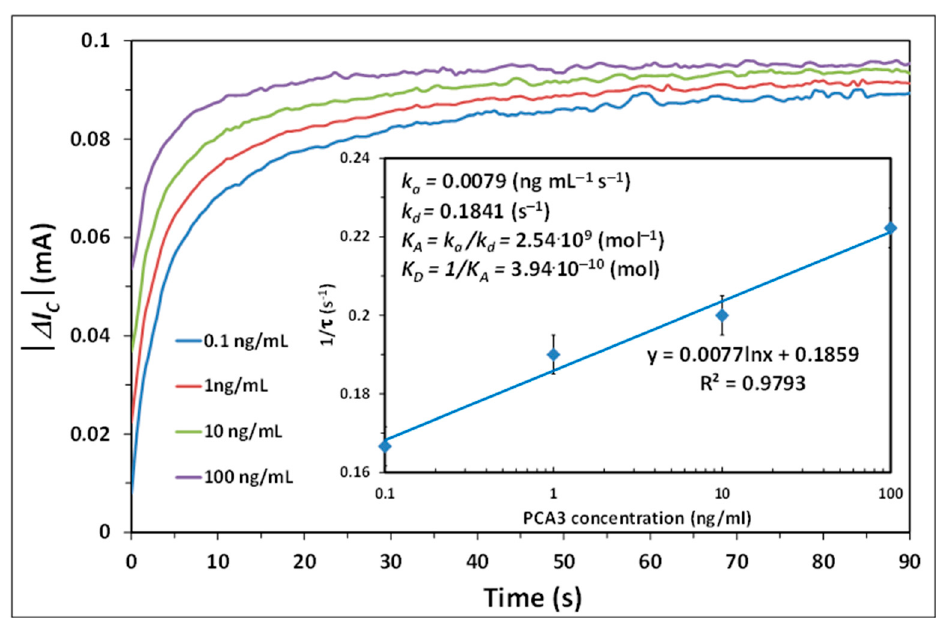
Figure 5. Typical kinetics of binding of PCA3 of different concentration to the aptamer. Inset illustrates the evaluation of the aptamer to PCA3 binding affinity.